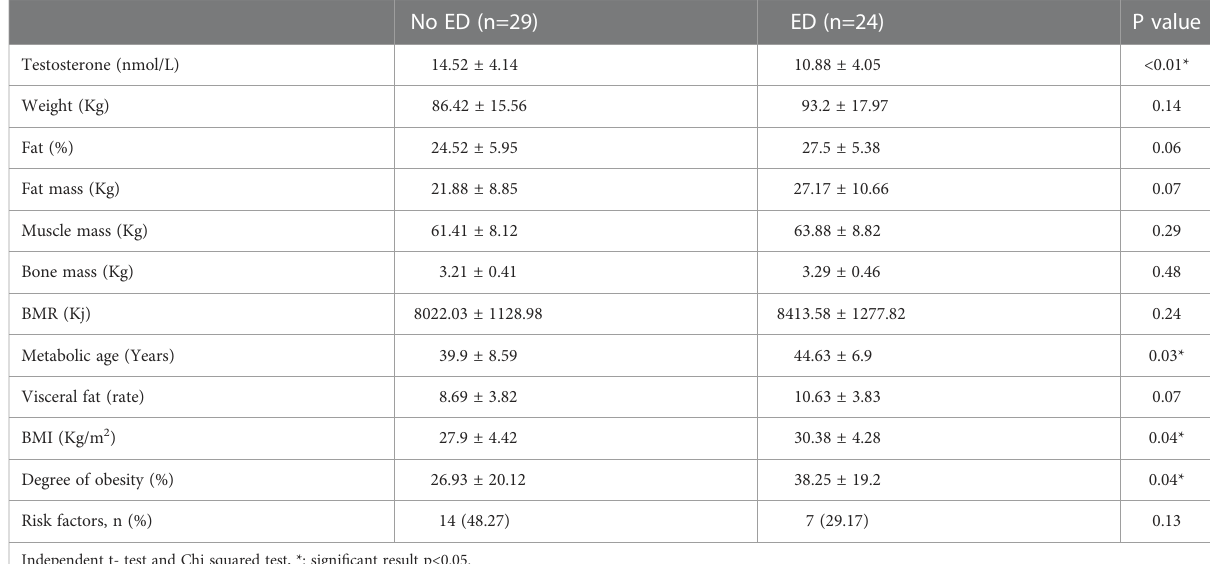
TABLE 3 Comparison of demographic, clinical and body composition analysis data in subjects < 40 years of age with/without erectile dysfunction.